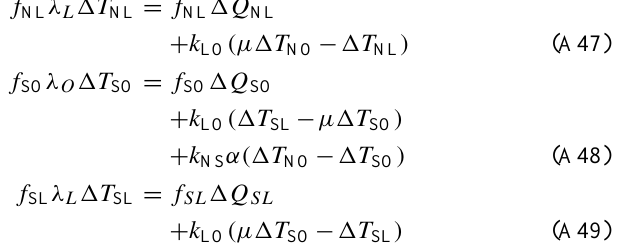
Fig. A1. The schematic structure of MAGICC’s upwelling- diffusion energy balance module with land and ocean boxes in each hemisphere. The processes for heat transport in the ocean are deep- water formation, upwelling, diffusion, and heat exchange between the hemispheres. Not shown is the entrainment and the vertically depth-dependent area of the ocean layers (see Fig. A2 and